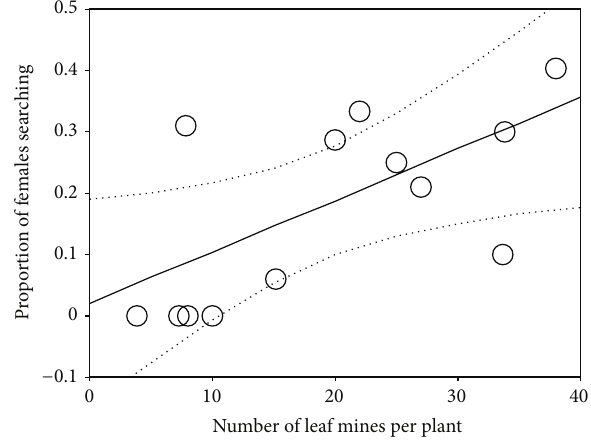
Figure 4: Relationship between levels of leaf miner infestation and proportions of female Neochrysocharis okazakii searching for hosts. Dot lines indicate 95% confidence